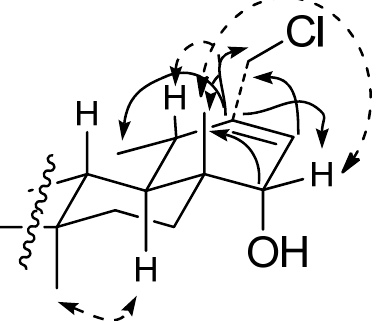
Figure 2. Selected correlations of 1 . Double-ended arrows indicate NOESY, and single arrows indicate HMBC (C to H)